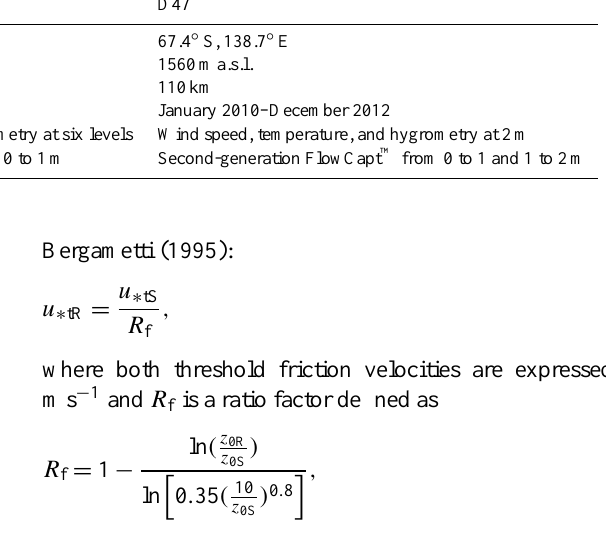
Table 1. Location and characteristics of the two automatic weather and snow stations (AWSS) used in the present study.